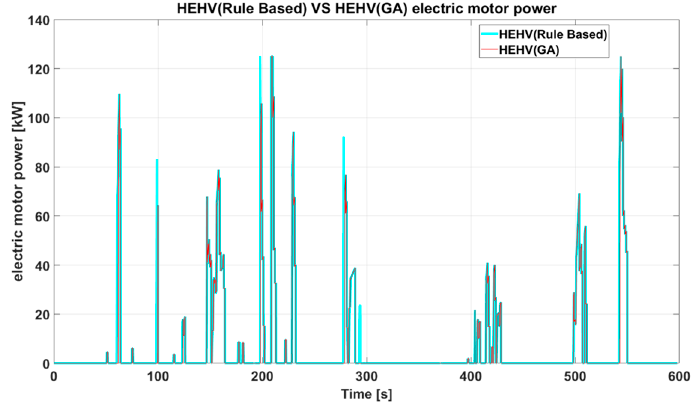
Figure 14. Power comparison between the HEHV (rule-based) and HEHV (GA) electric motors.